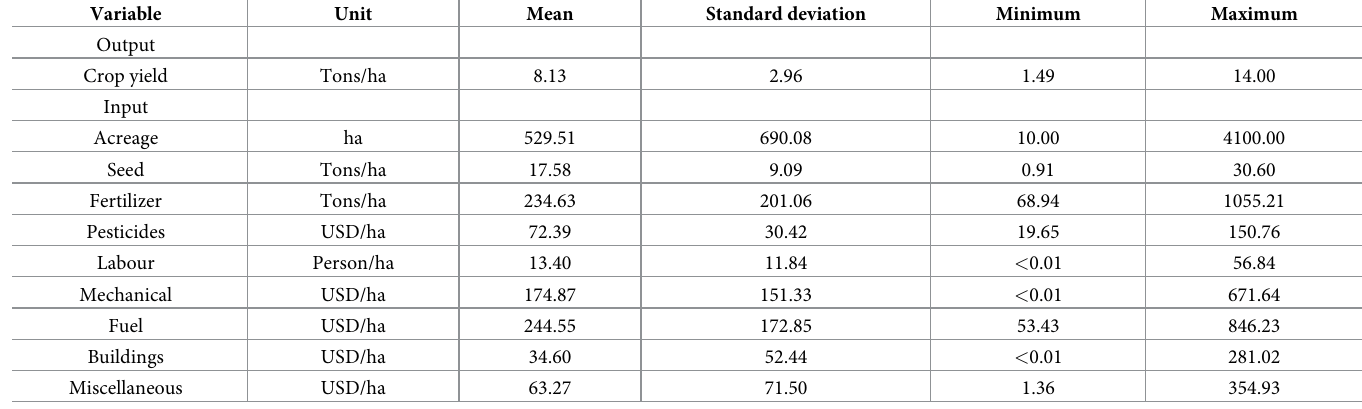
Table 2. Descriptive analysis of corn production input and output indicators in typical